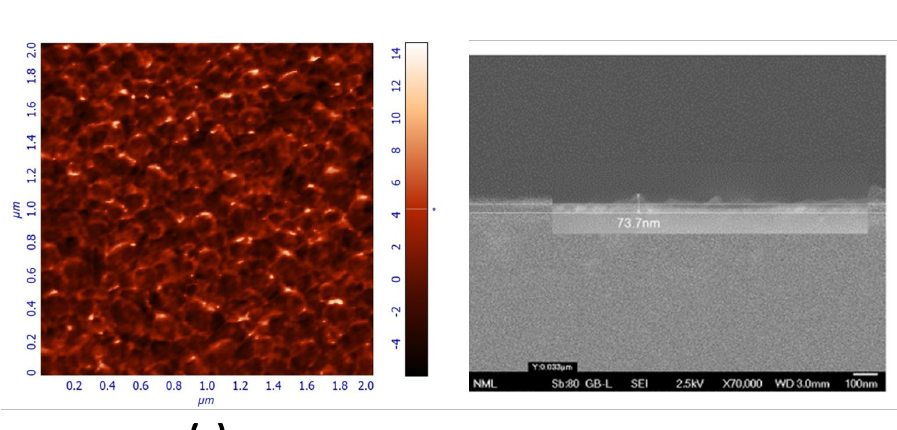
Figure 10. The XRD pattern for SnO 2 . 2.3. Electronic Characterization From the wide scan survey spectra, Figure 11, the photoelectron peaks of Sn, C, O and Cl were detected for all the samples. Detailed scans of the most prominent